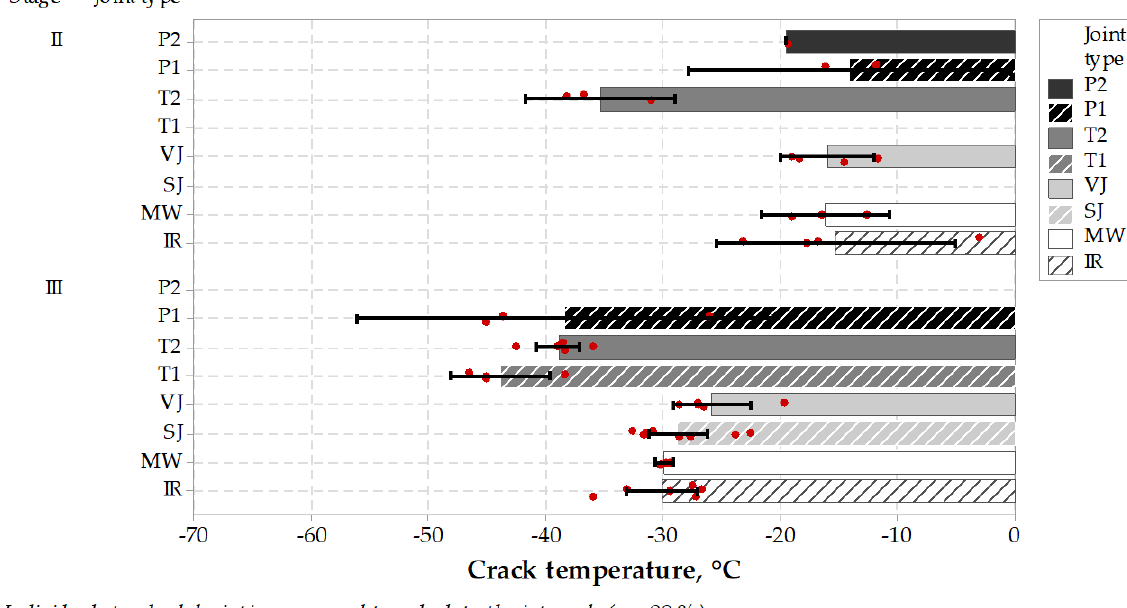
Figure 6. Test results of cracking temperature of specimens taken from longitudinal joints (the higher, the better). Table 8. Tukey’s pairwise comparison for TSRST test–maximum stress.